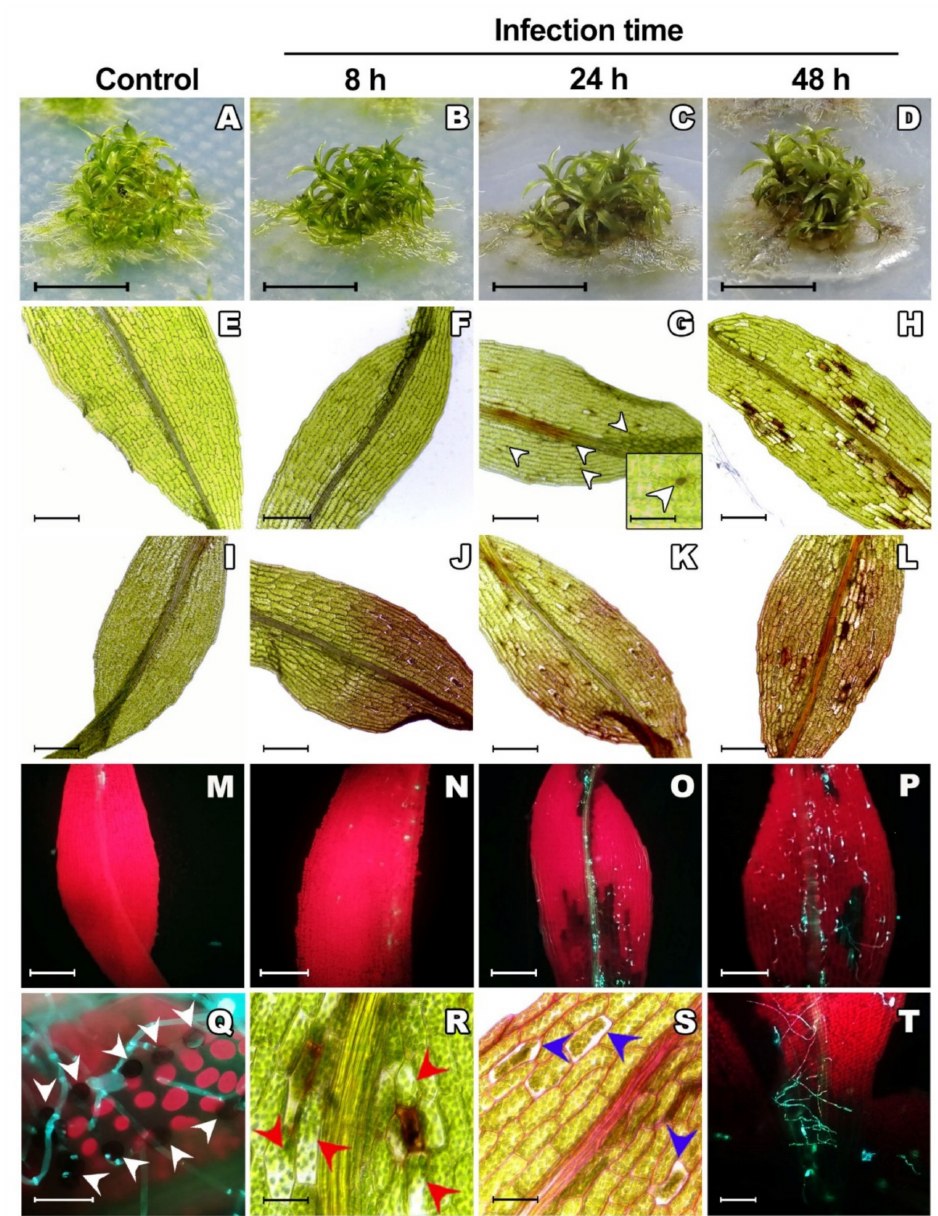
Figure 1. Symptom development in P. patens inoculated with C. gloeosporioides . ( A – D ) Images of P. patens colonies at different times of infection: control without inoculation, 8 h after inoculation (hai), 24 hai and 48 hai, respectively. Bars: 1 cm. ( E – H ) Images of unstained P. patens phyllids at different times of infection: control without inoculation, 8 hai, 24 hai and 48 hai, respectively. (G insert) Appressorium over a phyllid at 24 hai. White arrowheads point to appressoria; bar: 50 µ m. ( I – L ) Images of P. patens phyllids stained with safranin-O at different times of infection: control without inoculation, 8 hai, 24 hai and 48 hai, respectively. ( M – P ) Images of P. patens phyllids stained with solophenyl flavine at different times of infection: control without inoculation, 8 hai, 24 hai and 48 hai, respectively. Images E-P, bars: 200 µ m. ( Q ) Phyllid inoculated with C. gloeosporioides and stained with solophenyl flavine where appressoria formation can be seen at 24 hai (white arrowhead). ( R ) Phyllid inoculated with C. gloeosporioides , where the migration of chloroplasts to the site of infection can be seen (red arrowheads). ( S ) Phyllid inoculated with C. gloeosporioides and stained with safranin-O, where the shrinkage of the cytoplasm and staining of the plant cell walls can be seen, which reflects the reinforcement of the wall with phenolic compounds (24 hai). ( T ) Phyllid inoculated with C. gloeosporioides at 24 hai and stained with solophenyl flavine, where hyphae growth can be seen. Images Q-T, bars: 50 µ